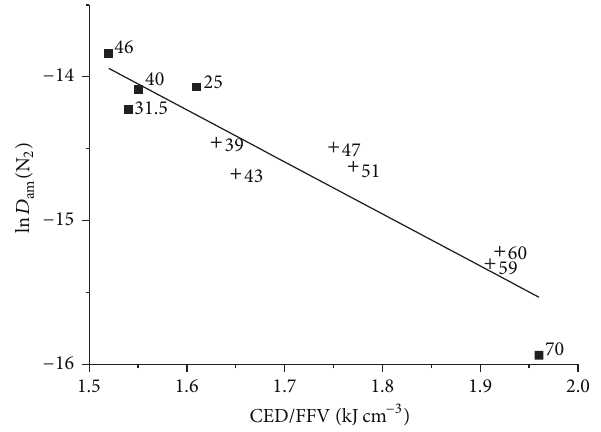
Figure 5: Correlation of N 2 diffusion coefficient for ( ◼ ) EVA copolymers and for (+) blends. The straight line represents linear fit to the experimental data. The obtained parameters of (14) are 𝑎 󸀠 = −8.4 , 𝑏 󸀠 = 3.6 , and 𝑅 2 = 0.86 .